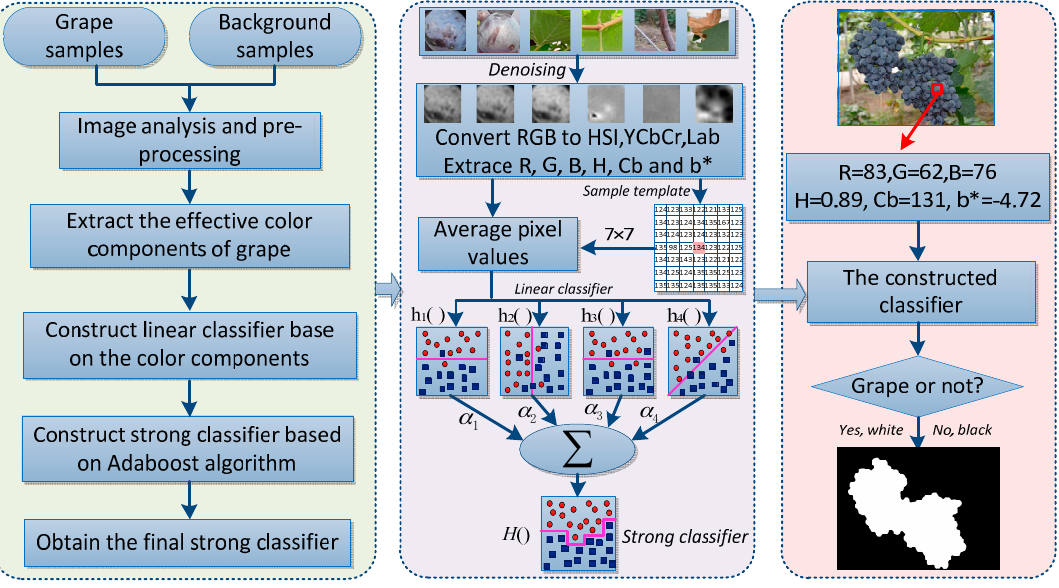
Figure 3. Principle of the proposed approach.